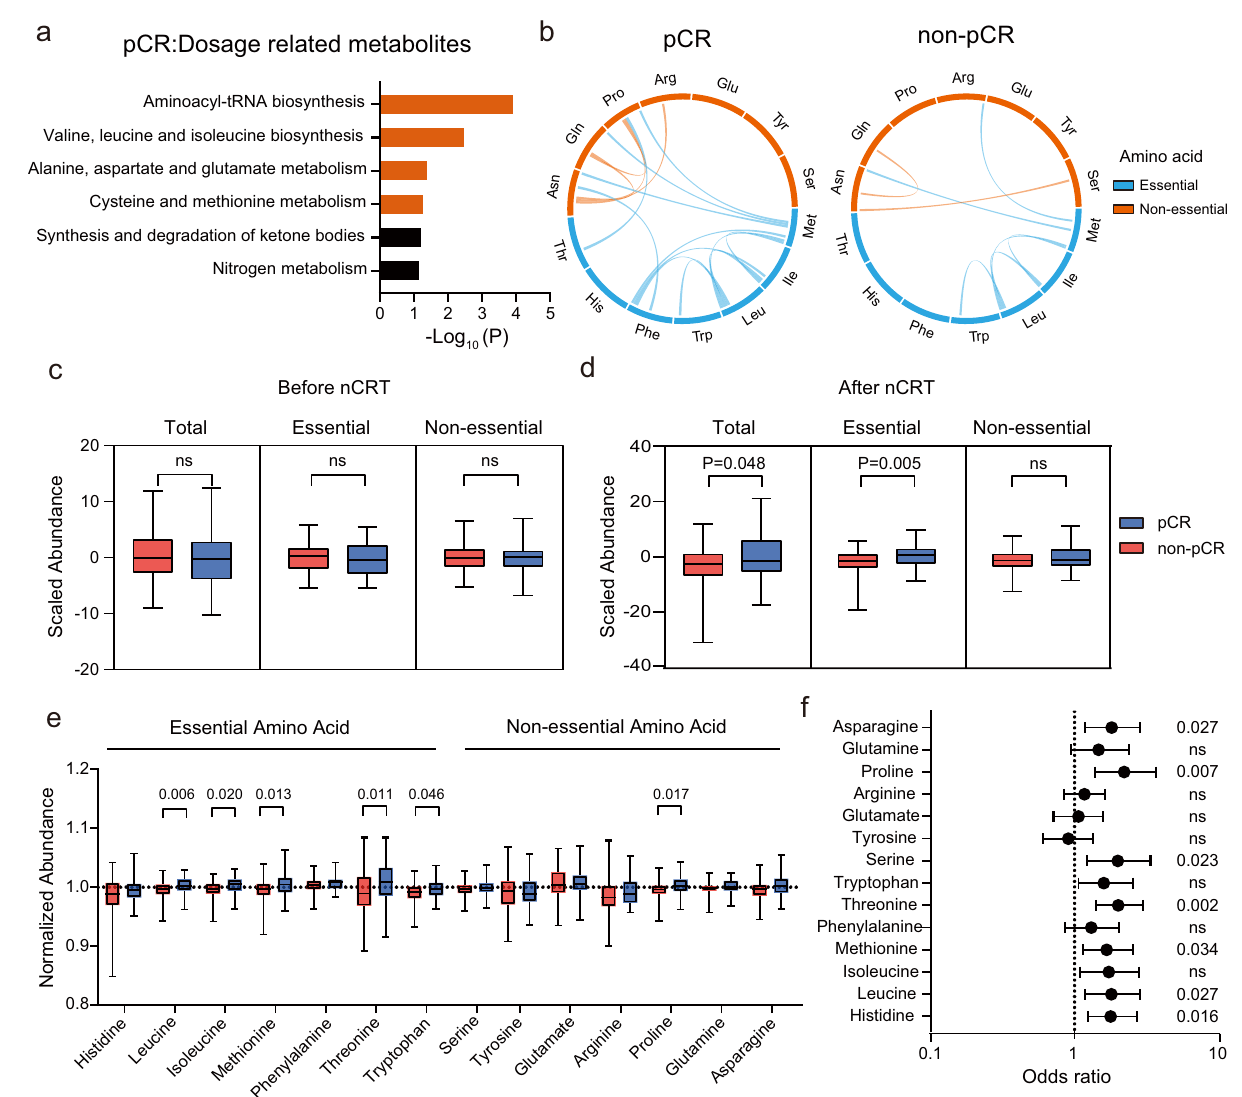
Fig. 5 | Elevatedessential amino acids are bene fi cial to pCR in nCRT. a Pathway enrichment analysis of metabolites related to both nCRT dosage and pCR status (Hypergeometric test; P <0.05). b Metabolic correlation between two amino acids inpCRandnon-pCRpatients(Pearsoncorrelation; r >0.60andtwo-sidedStudent ’ s t test P <0.05). c , d LevelsofaminoacidsinserumsamplesofpCR( n =38)andnon- pCR( n =116)patientsbeforeandafternCRT: c ,beforenCRTatbaseline;d,afterthe 25thnCRT(Two-sidedWilcoxontest;ns,notsigni fi cant). e Levelsofaminoacidsin